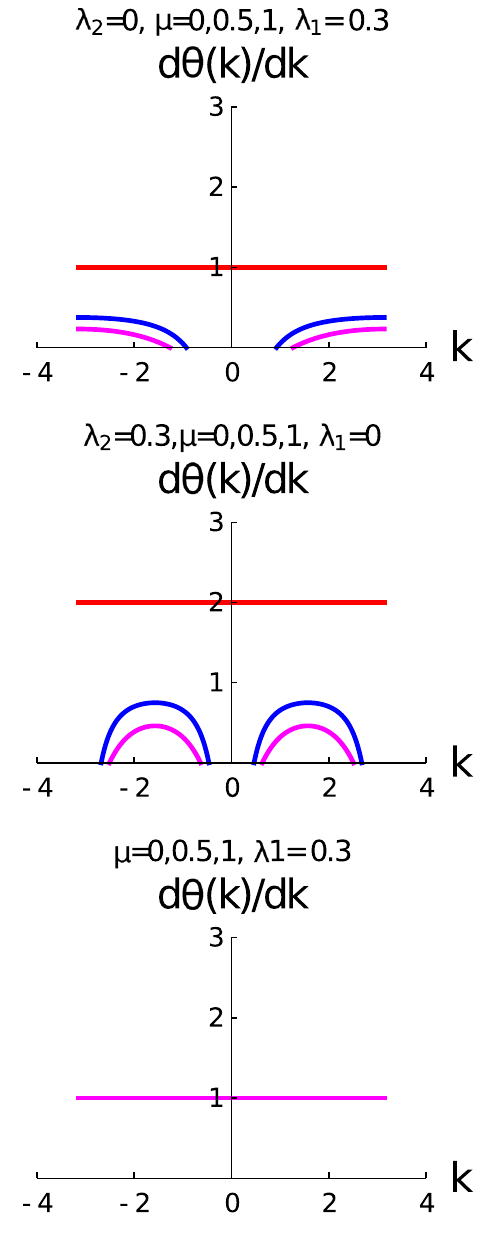
( ) with k . The upper, middle and lower rows are λ dk